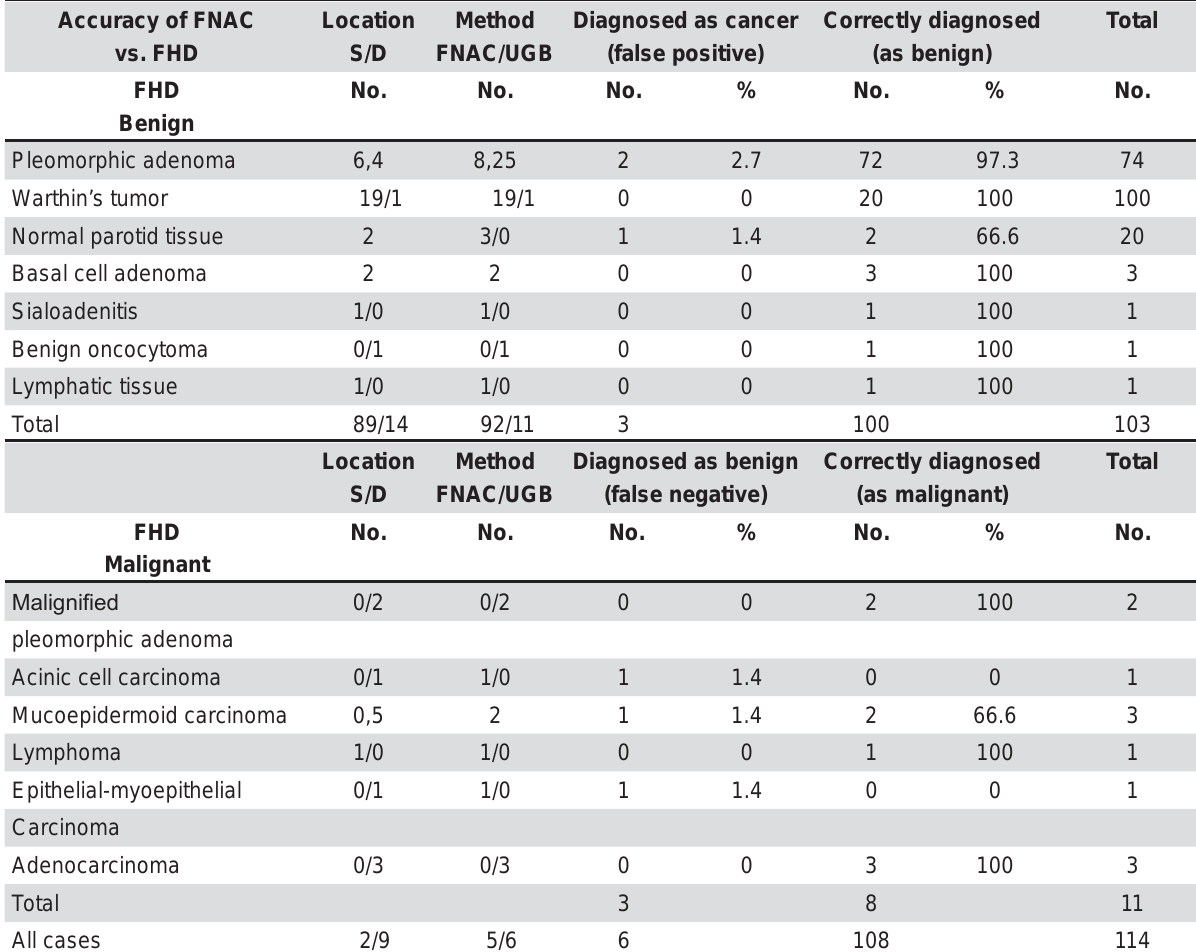
Table 1- (cid:55)(cid:75)(cid:72)(cid:3)(cid:68)(cid:70)(cid:70)(cid:88)(cid:85)(cid:68)(cid:70)(cid:92)(cid:3)(cid:82)(cid:73)(cid:3)(cid:191)(cid:81)(cid:72)(cid:16)(cid:81)(cid:72)(cid:72)(cid:71)(cid:79)(cid:72)(cid:3)(cid:68)(cid:86)(cid:83)(cid:76)(cid:85)(cid:68)(cid:87)(cid:76)(cid:82)(cid:81)(cid:3)(cid:70)(cid:92)(cid:87)(cid:82)(cid:79)(cid:82)(cid:74)(cid:92)(cid:3)(cid:11)(cid:41)(cid:49)(cid:36)(cid:38)(cid:12)(cid:17)(cid:3)(cid:38)(cid:82)(cid:80)(cid:83)(cid:68)(cid:85)(cid:76)(cid:86)(cid:82)(cid:81)(cid:3)(cid:82)(cid:73)(cid:3)(cid:41)(cid:49)(cid:36)(cid:38)(cid:3)(cid:68)(cid:81)(cid:71)(cid:3)(cid:191)(cid:81)(cid:68)(cid:79)(cid:3)(cid:75)(cid:76)(cid:86)(cid:87)(cid:82)(cid:79)(cid:82)(cid:74)(cid:76)(cid:70)(cid:68)(cid:79)(cid:3)(cid:71)(cid:76)(cid:68)(cid:74)(cid:81)(cid:82)(cid:86)(cid:76)(cid:86)(cid:3)